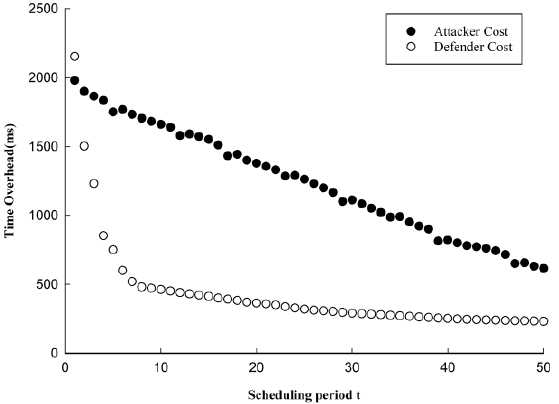
Figure 17. Attack – defense time cost. Figure 17. Attack–defense time